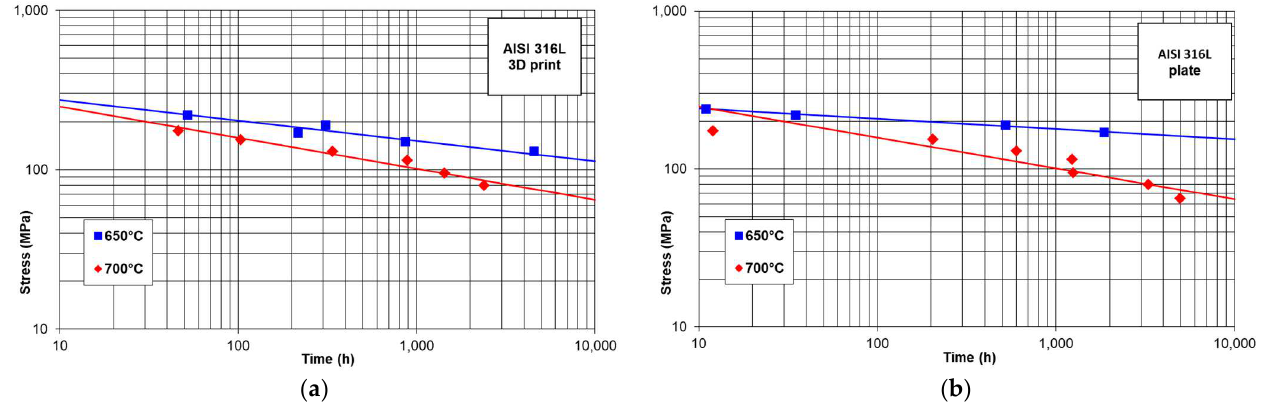
Figure 6. Comparison of the results of stress rupture tests of the 3D block ( a ) and hot-rolled plate ( b ). Lines represent the corresponding Norton equations. Table 5. Constants of Norton equation for the 3D and hot-rolled material of AISI 316L steel. Material Temperature (°C) Hot-rolled plate